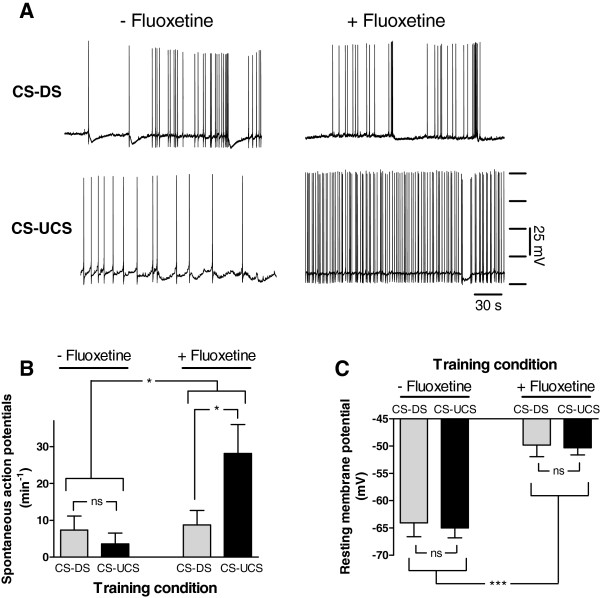
Effect of fluoxetine treatment on electrical activity CGCs. A. Examples of intracellular recording of spontaneous electrical activity in CGCs of control (CS-DS) and conditioned (CS-UCS) senior animals treated with vehicle only (−Fluoxetine) or with fluoxetine (+ Fluoxetine). B. Average number of spontaneous action potentials of CGCs in vehicle only and fluoxetine treated conditioned and control animals. Fluoxetine caused a significant increase in the number of spontaneous action potentials but only in CGCs from conditioned (CS-UCS) animals. No significant effect on electrical activity was observed in fluoxetine treated unconditioned control animals (CS-DS) or vehicle treated conditioned and unconditioned animals. C. CGC resting membrane potential of fluoxetine treated snails was significantly more depolarized compared with vehicle only treated animals. Behavioural conditioning had no effect on resting membrane potential in both treatments. * = p < 0.05, *** = p < 0.001, ns = non-significant.